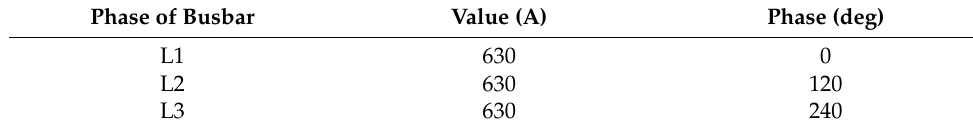
Table 3. Current excitations in 3-phase busbar in “Eddy Current” solution type.